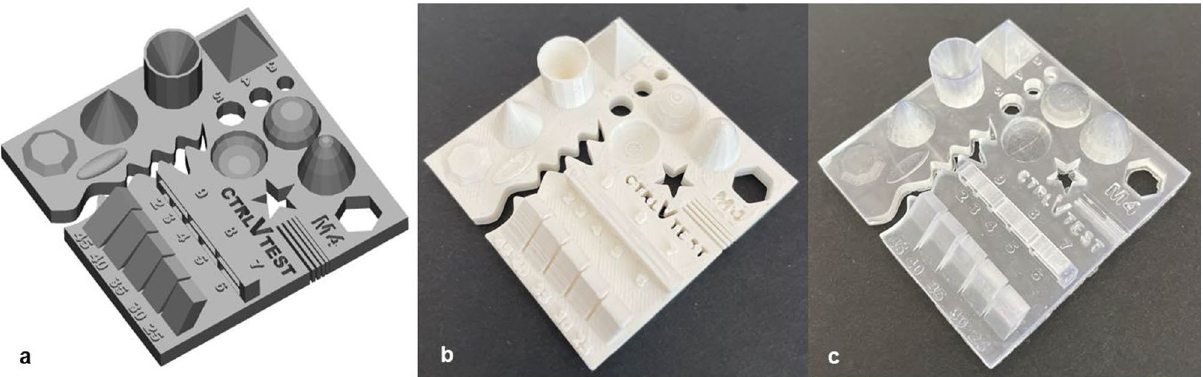
Figure 2. The specification of the test part. ( a ) 3D model, ( b ) a test part printed by materials extrusion (ME), and ( c ) a test part printed by vat photopolymerization (VP).